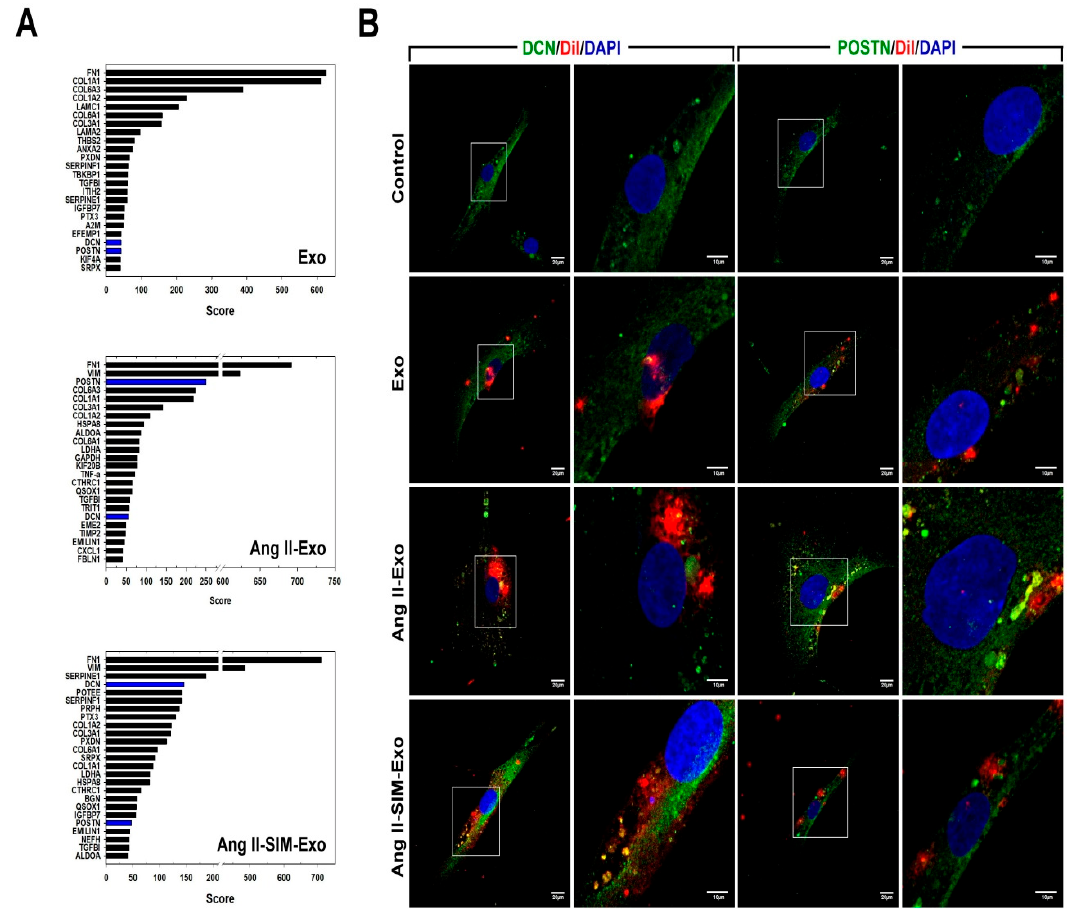
Figure 6. Simvastatin regulates HCM-derived exosome protein content in vitro. HCM-derived exosome proteins were isolated after Ang II or Ang II + SIM treatment and identified using nano UPLC-MS / MS ( A ). To confirm exosomal decorin (DCN) and periostin (POSTN) protein expressions, HCM-derived exosomes were labeled with DiI dye (5 µ g / mL, red florescence) for 1 h, and then incubated with HCF cells for 24 h. Immunofluorescence staining was performed (DCN and POSTN, green fluorescence; exosomes-labeled with DiI dye, red fluorescence; nucleus, blue fluorescence) in HCF cells ( B ). A representative image from three independent experiments is shown.